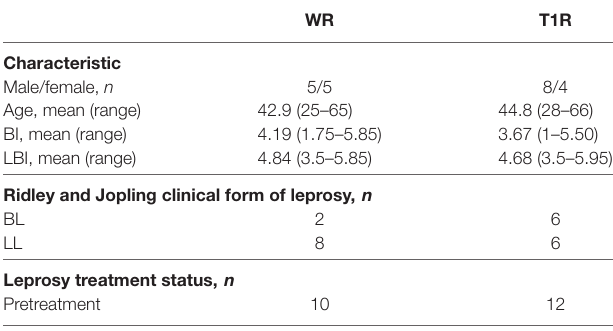
Table 1 | Baseline characteristics of the multibacillary patients included in the